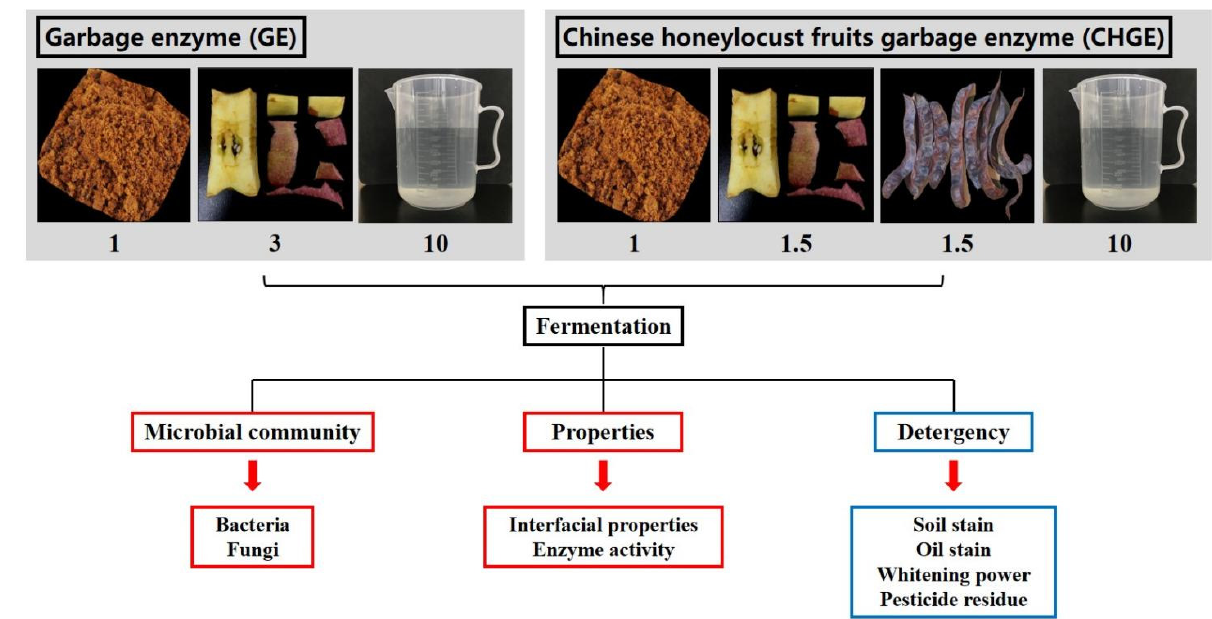
Figure 1. Schematic representation of the experiment workflow.